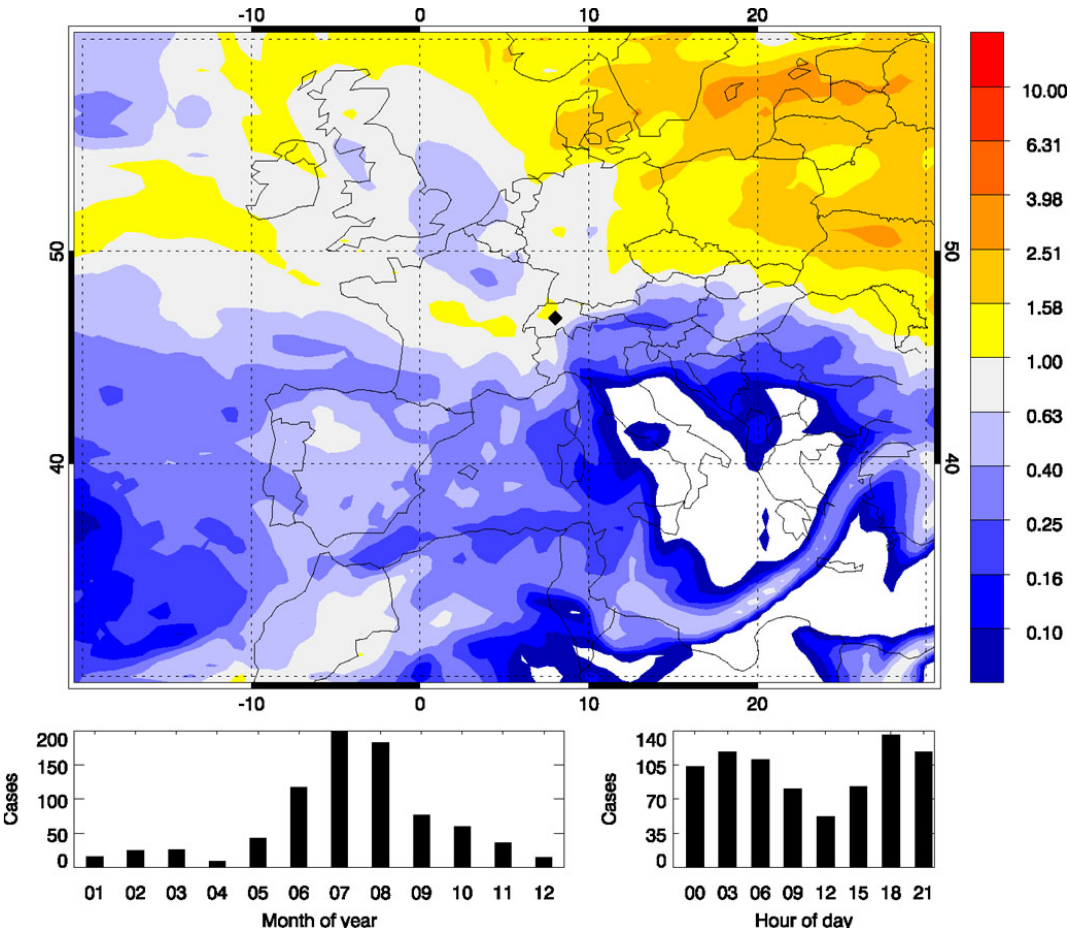
Fig. 13. Relative footprint map corresponding to low CO 2 but high APO and O 2 (subset 4). See Fig. 10 for further